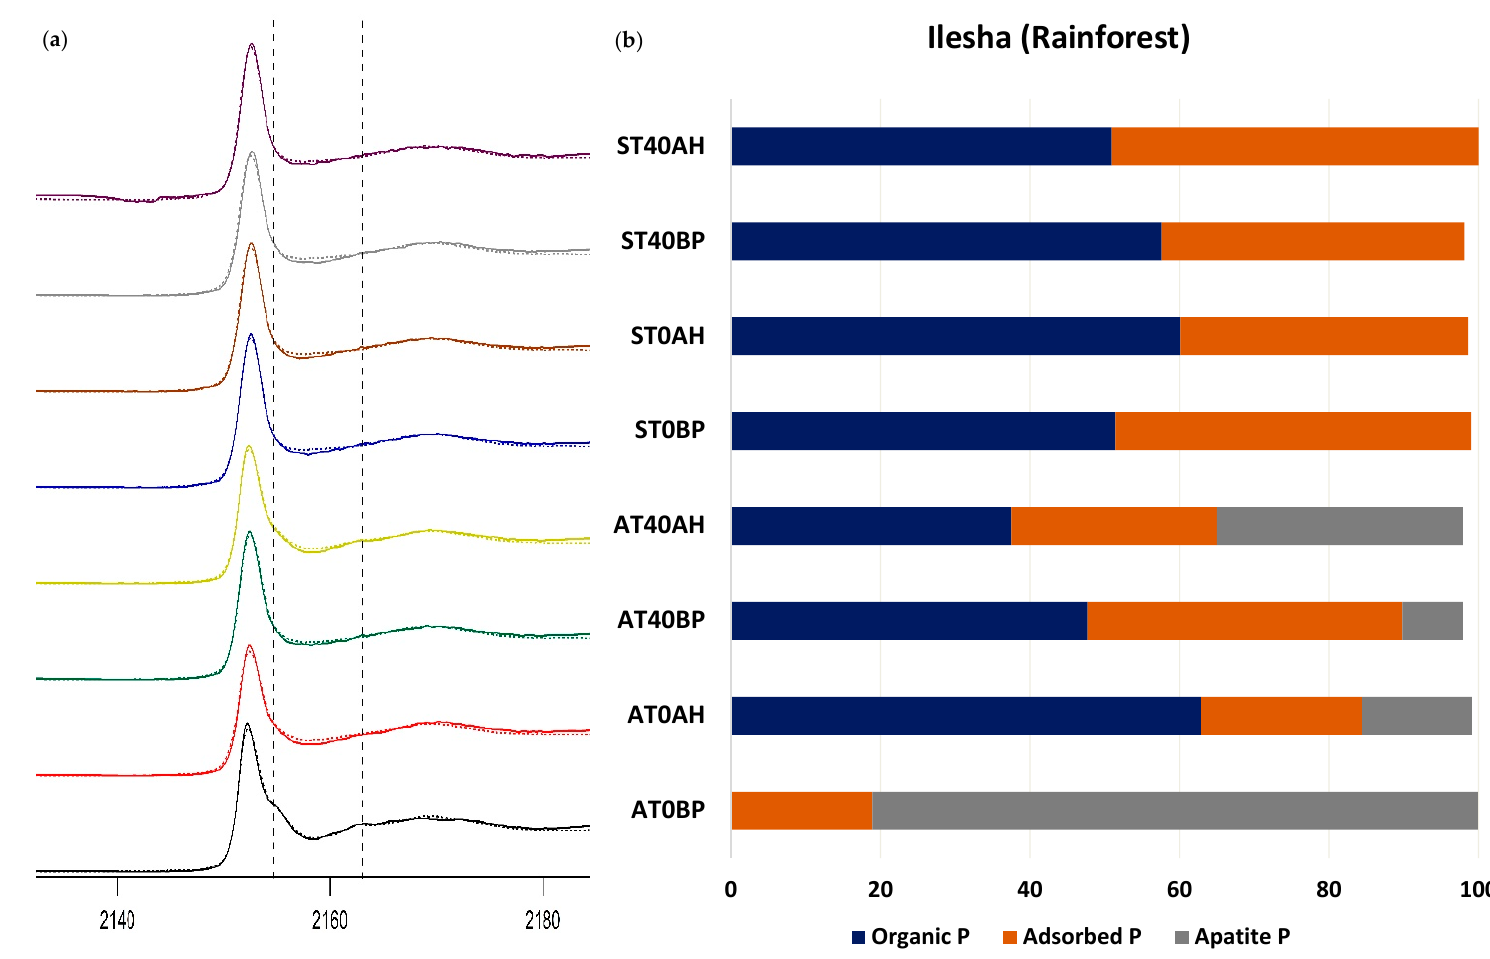
Figure 7. ( a ) Normalized P K-edge X-ray absorption near-edge structure (XANES) spectra showing the linear combination fitting (LCF) results of rainforest (Ilesha) soils cultivated with Amaranthus cruentus (A) and Solanum macrocarpon (S) amended with poultry manure alone (T0) and that amended with poultry manure and 40 kg N/ha of urea (T40). BP means before planting, and AH means after harvest. ( b ) Proportion of P compounds found in the LCF of soils in ( a ).